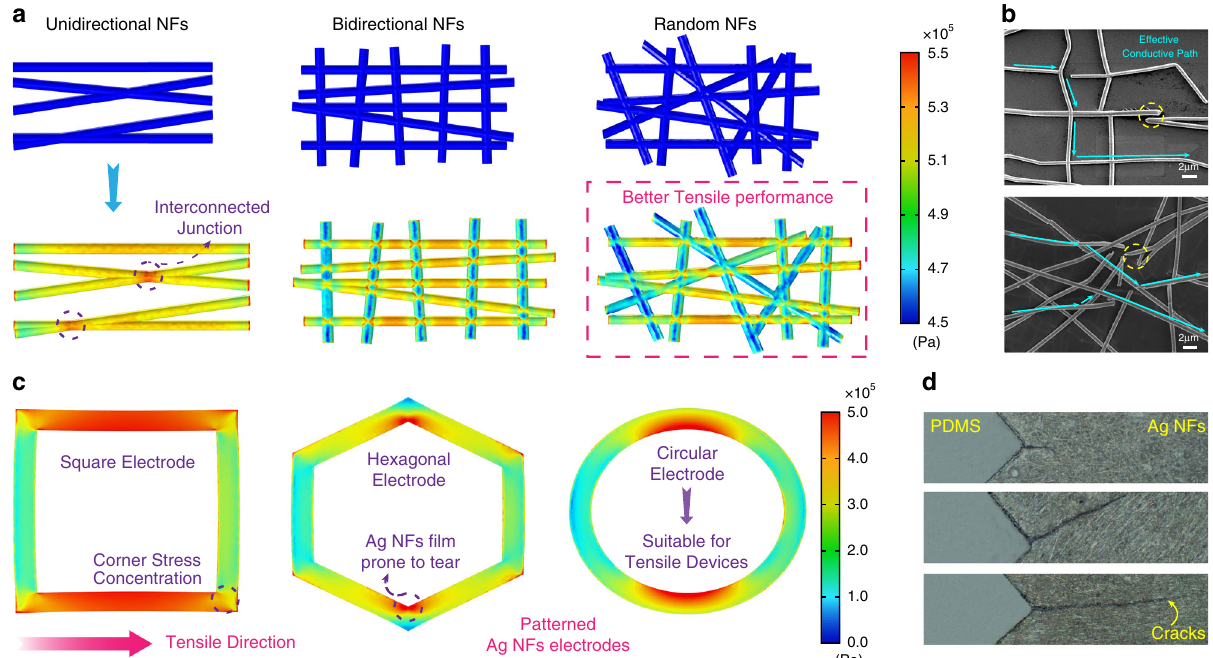
Fig. 4 Simulations of the mechanical properties of various Ag NFs networks. a Stress distribution of Ag NFs networks under tensile strain with different orientations (unidirectional, bidirectional, random). b SEM images of the Ag NFs networks under tensile strain (Top: bidirectional NFs, bottom: random NFs). The NFs break under stress, but there are still conductive paths in the electrodes. c Stress distribution of different patterned Ag NFs electrodes (square, hexagonal and circular) under strain. Stress concentration tends to occur in the corners of the electrodes. d Optical images of large cracks at the corners of square electrodes with the increasing strain (Top to bottom: 15%, 45% and 60%).